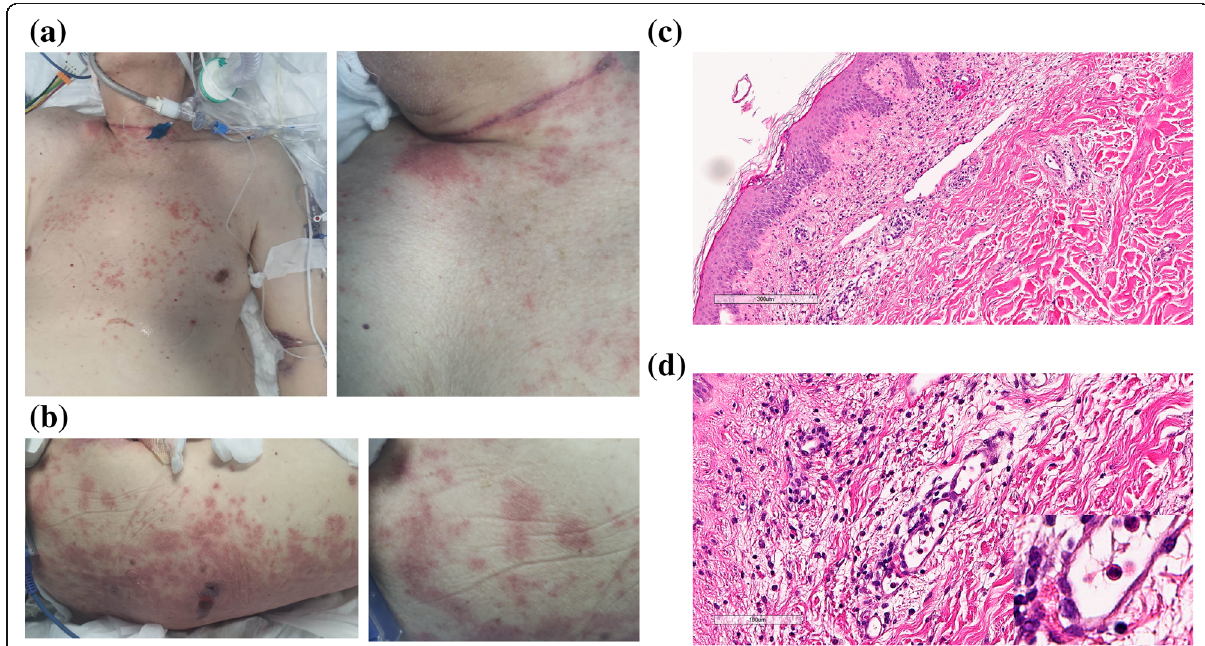
Fig. 1 a Purpuric maculo-papular rash involving trunk, neck and shoulders; b Back lesions with limited epidermal detachment; c - d The papillary and superficial dermis were edematous and populated mainly by perivascular lympho-granulocytic inflammatory infiltrate, with associated granulocyte intraepithelial exocytosis, and irregular spongiosis (blue arrow). Superficial dermal micro-areas of erythrocytic extravasation (yellow arrow) and endothelial “ swelling ” (green arrow in fig. c and fig. d ; at higher magnification in inset on the right) were observed (C:H&E, 8x; D,:H&E, 20x, inset 40x). Legend: H&E = hematoxylin and eosin